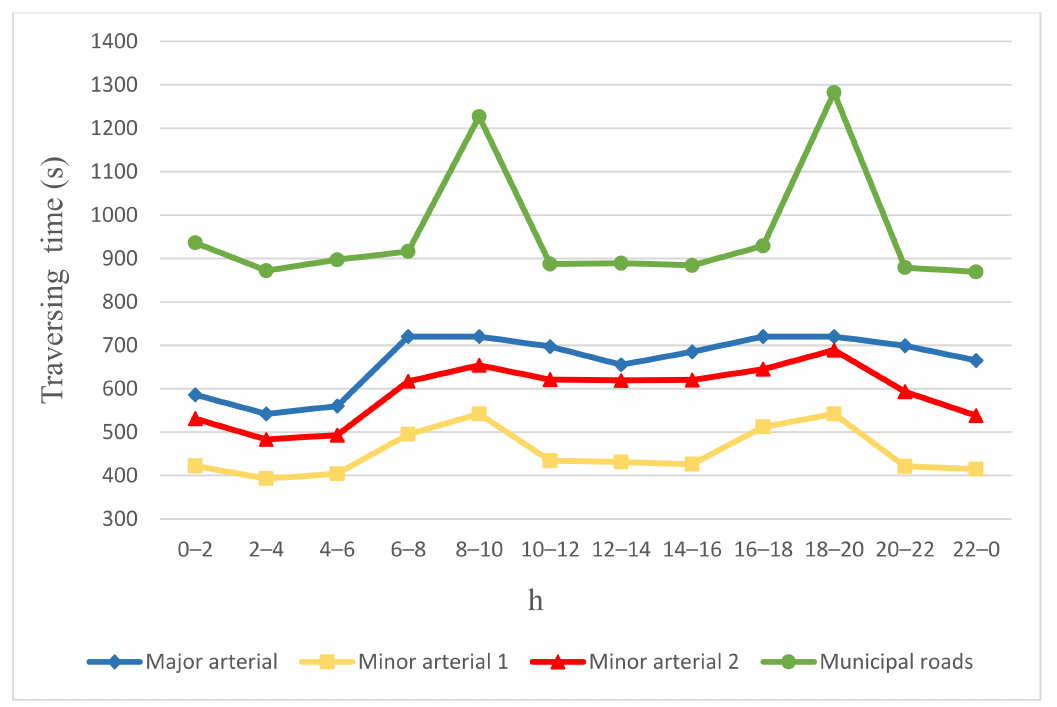
Figure 14. Traversing times of PEVs/SAEVs after enforcing real-time traffic volume